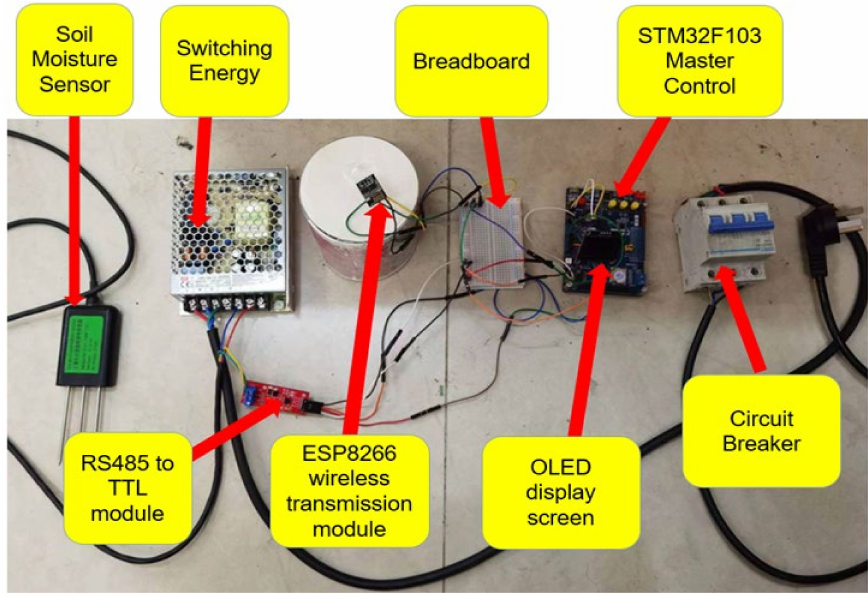
Figure 22. Humidity measurement and transmission system.